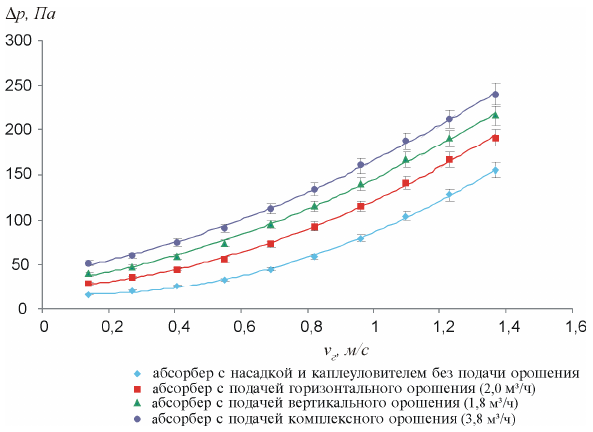
Рис. 4. Зависимость гидравлического сопротивления абсорбера с волокнистой насадкой от линейной ско- рости газов Fig. 4. Dependence of hydraulic resistance of absorber with fibrous nozzle on linear gas speed